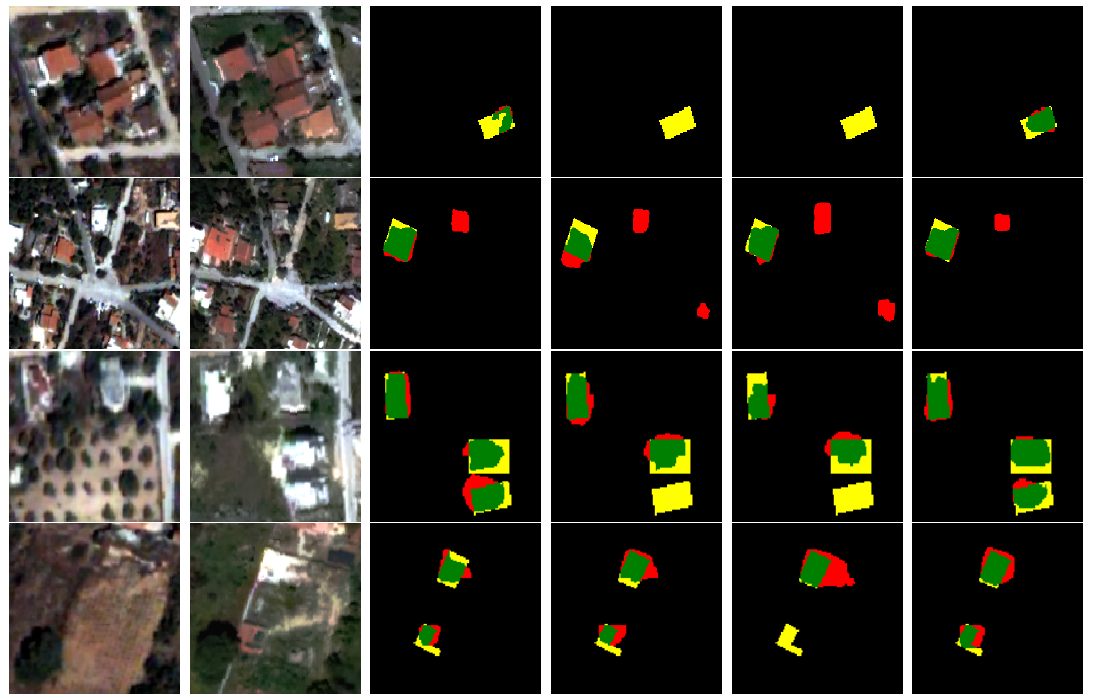
Figure 2. Qualitative evaluation on zoomed regions of the Attica VHR testing areas for the building change detection task. 1st column: RGB images of 2006, 2nd column: RGB images of 2011, 3rd column: multi-task FC-Siam-Conc with 5 dates, 4th column: multi-task FC-Siam-Diff with 2 dates, 5th column: FC-EF with 5 dates, 6th column: multi-task L-UNet with 5 dates [ Green : True Positives, Black : True Negatives, Red : False Positives, Yellow : False Negatives] false positive pixels. Regarding the third row, multi-task FC- Siam-Diff with 2 dates and FC-EF with 5 dates have failed to identify certain building changes while finally, in the last row all methods have detected the building changes adequately ex-